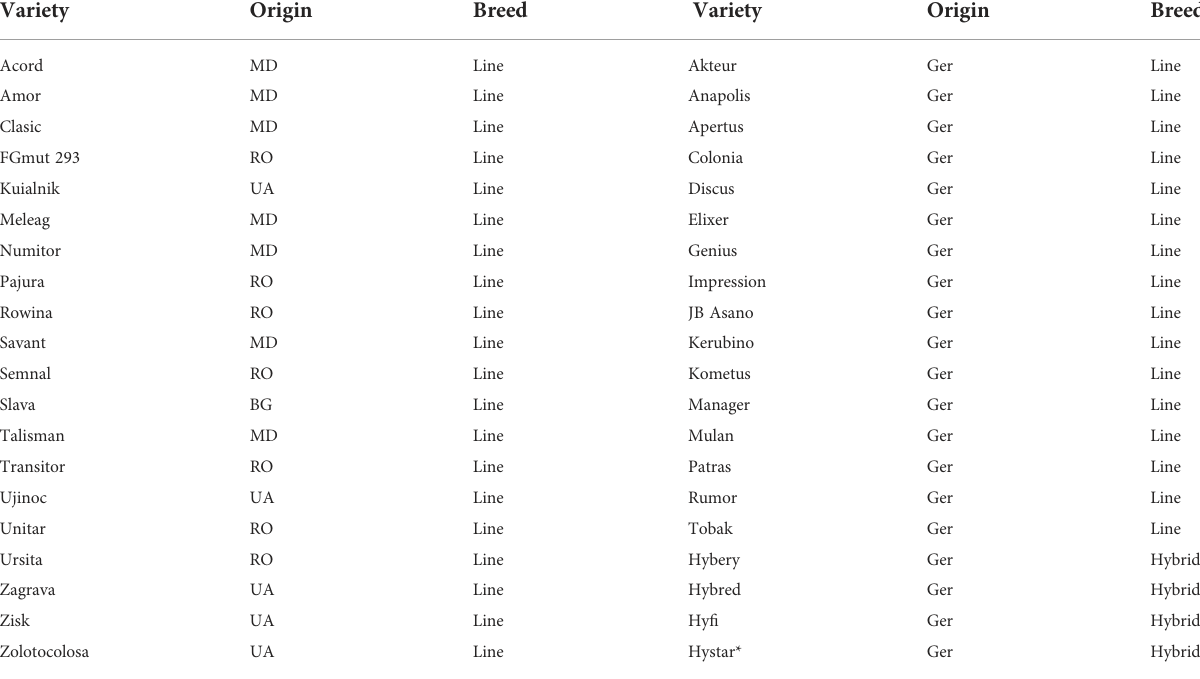
TABLE 1 Wheat varieties used in the fi eld experiments and their country of origin BG, Bulgaria; MD, Republic of Moldova; RO, Romania; UA, Ukraine; GER, Germany.